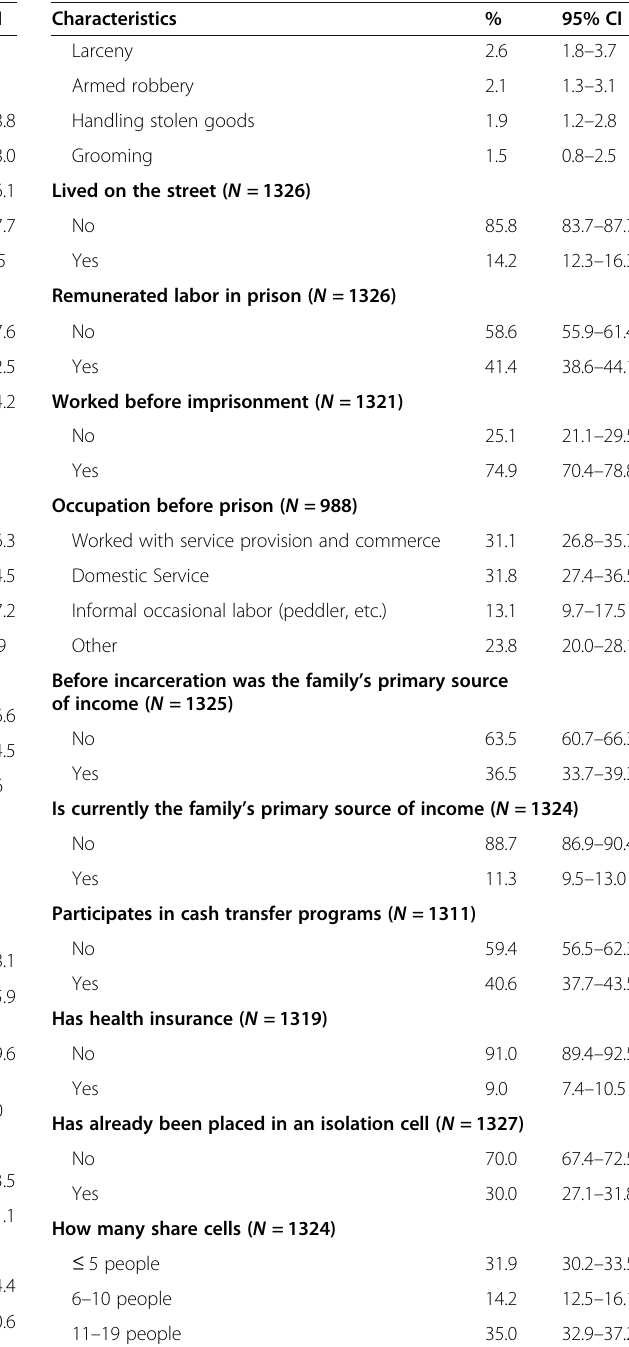
Table 1 Sociodemographic and prison characteristics of